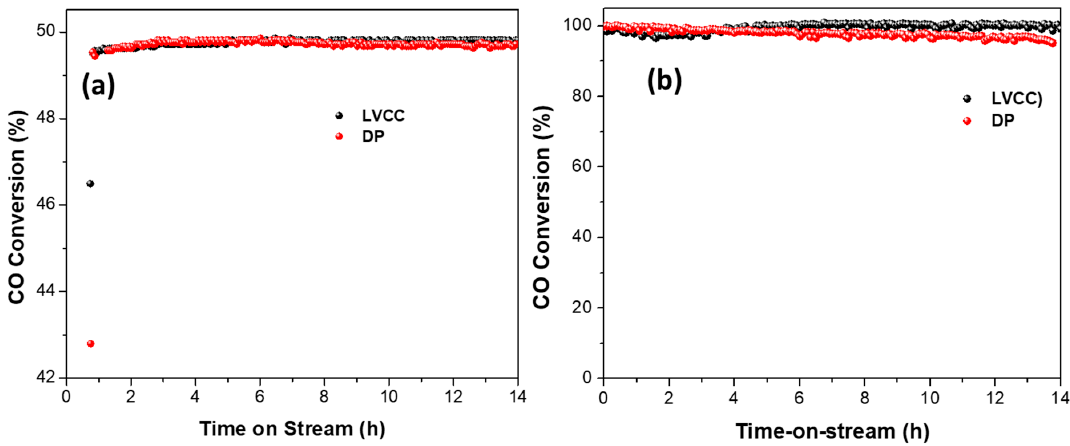
Figure 11. Long-term stability of Au/CeO 2 prepared by LVCC and DP methods at ( a ) 50% conversion and ( b ) 100% conversion. Sample mass = 10 mg, flow rate = 100 cc/min.